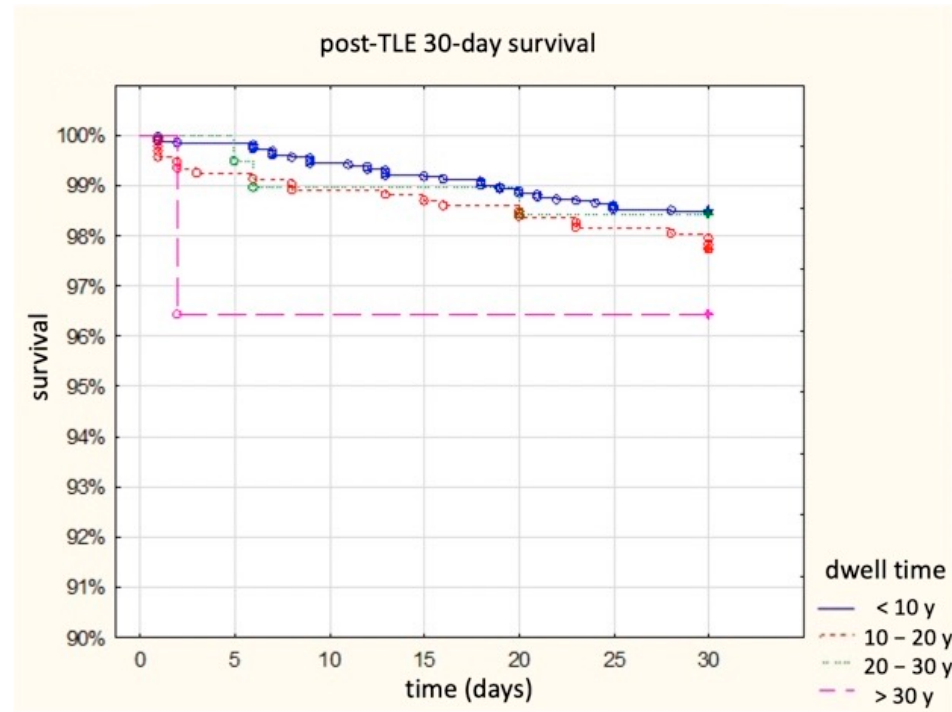
Figure 1. Survival after TLE in subgroups of patients depending on the sum of dwell time of the oldest extracted lead in 30-day follow-up